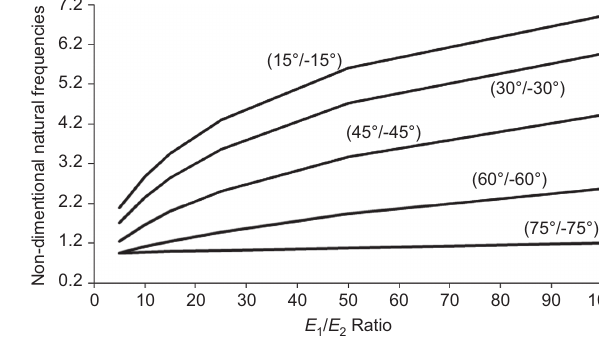
Figure 9 Non-dimensional natural frequencies of clamped-clamp angle-ply composite beam depending on E L / h = 10.